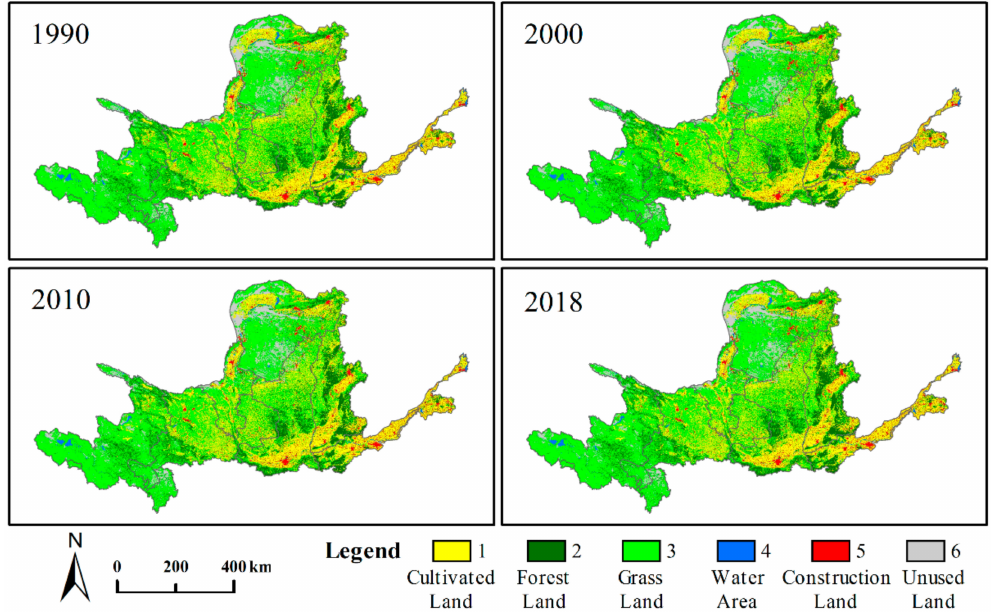
Figure 2. Land use distribution of the Yellow River Basin (YRB) from 1990 to